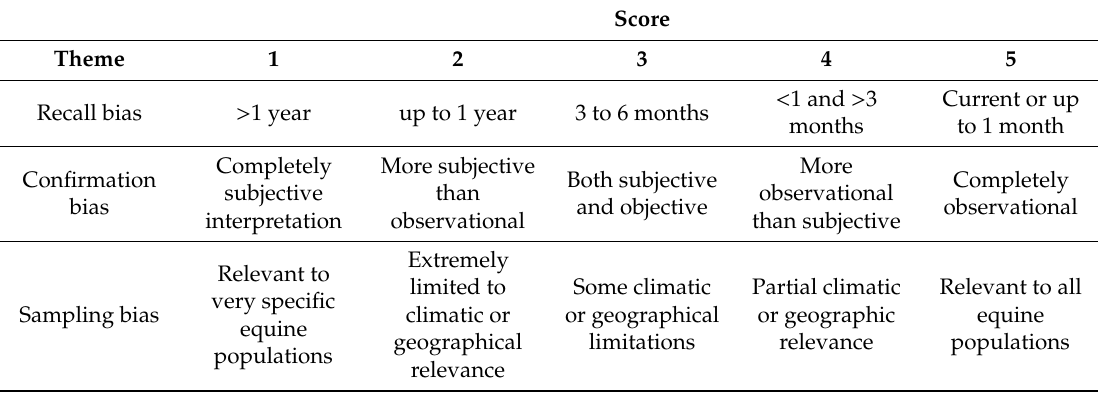
Table 2. Scoring system used for three themes that relate to potential bias in surveys.